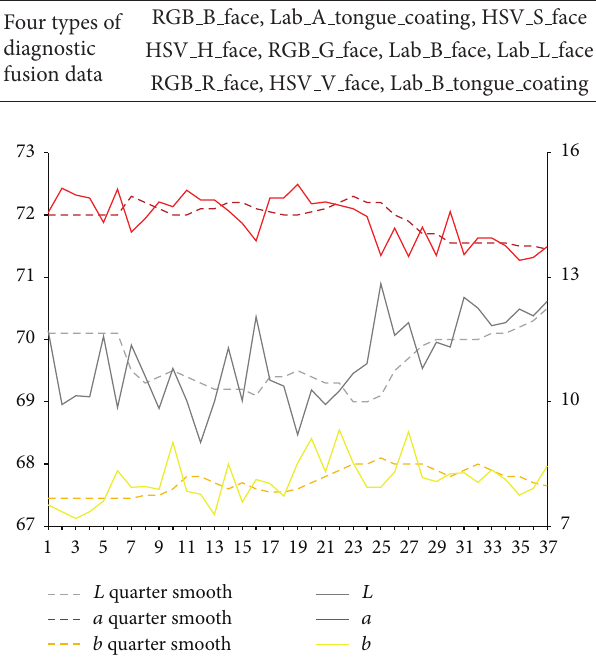
Figure 3: Lab value changing trend of tongue body.